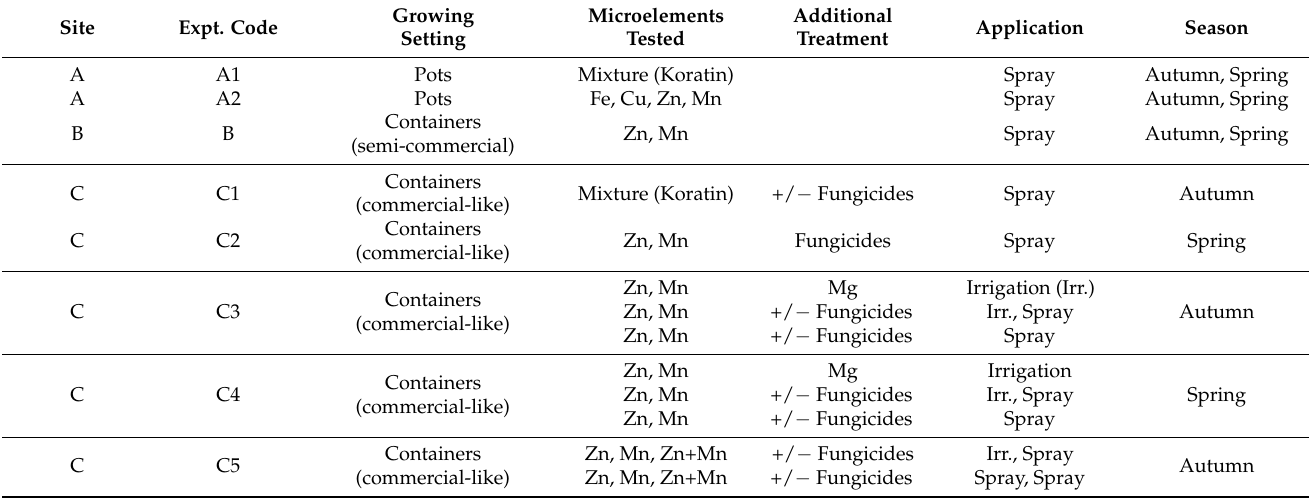
Table 5. Experimental setup, factors tested, application methods and growing seasons 1